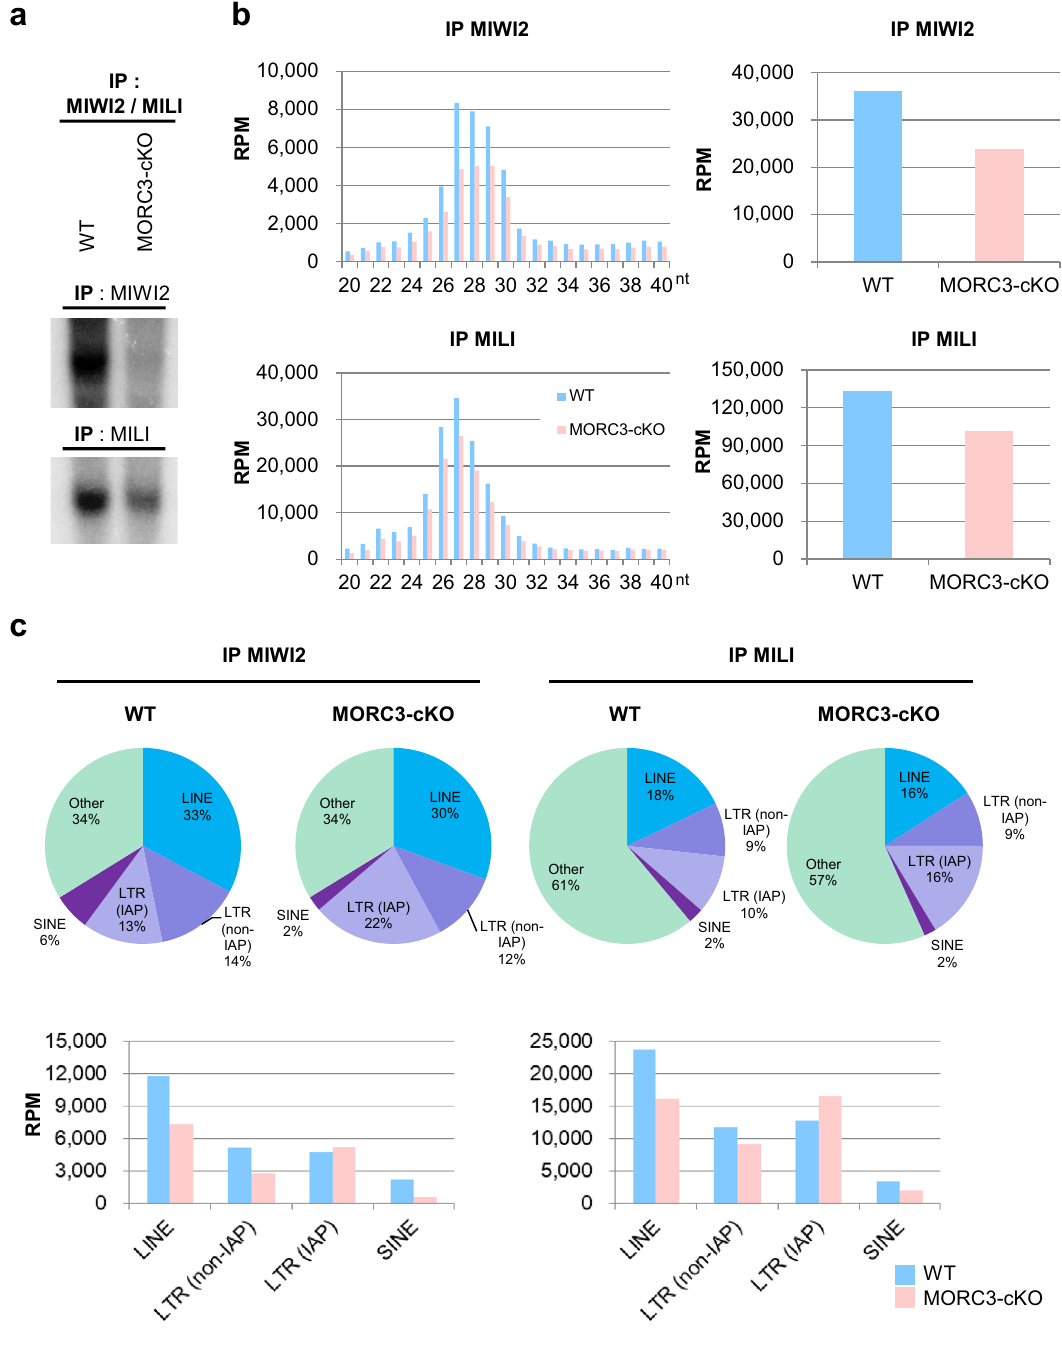
Figure 5. MIWI2- and MILI-associated piRNAs in the MORC3 mutant embryonic testes. ( a ) MIWI2- and MILI- bound piRNAs. The immunoprecipitated RNAs from E16.5 wild type and MORC3-cKO testes were 32 P-end-labeled and separated in 15% denaturing urea-polyacrylamide gel. Uncropped images were shown in Supplementary Figure S4d. ( b ) Length distribution of small RNAs associated with MIWI2 and MILI from E16.5 wild type and MORC3-cKO testes. The small RNAs were analyzed after ribosomal RNA (rRNA), micro RNA (miRNA), and transfer RNA (tRNA) mapped reads were removed by CLC Genomics Workbench (left). Reads of 25–31 nt small RNAs corresponding to piRNAs in individual samples (right). The accession number of deep sequencing data is DRA009594. ( c ) Genomic annotation and classification of repeat piRNAs based on retrotransposon class in MIWI2- and MILI-associated piRNA libraries from wild type and MORC3-cKO testes (upper). Reads of MIWI2- and MILI-associated piRNAs corresponding to LINE, LTR (non-IAP), LTR (IAP), and SINE in individual repeat piRNAs (bottom). ( d ) Reads of 25–31 nt small RNAs derived from each strand (sense or antisense) corresponding to LINE1 A (M13002), LINE1 TF (D84391), and IAP (M17551) sequences in the MIWI2- and MILI-associated piRNA libraries from wild type and MORC3-cKO testes. ( e ) Co-immunostaining of the testes of the E16.5 MORC3-heterozygous and the mutant mice with anti-MIWI2 antibody (red), anti-MORC3 antibody (green), and DAPI (blue) for DNA are shown. Scale bar, 20